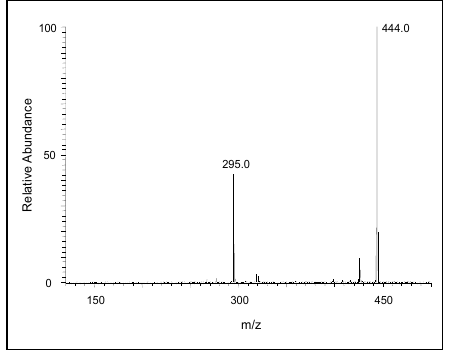
Figure 7. The CID mass spectrum of the ion with an m/z value of 444 amu.